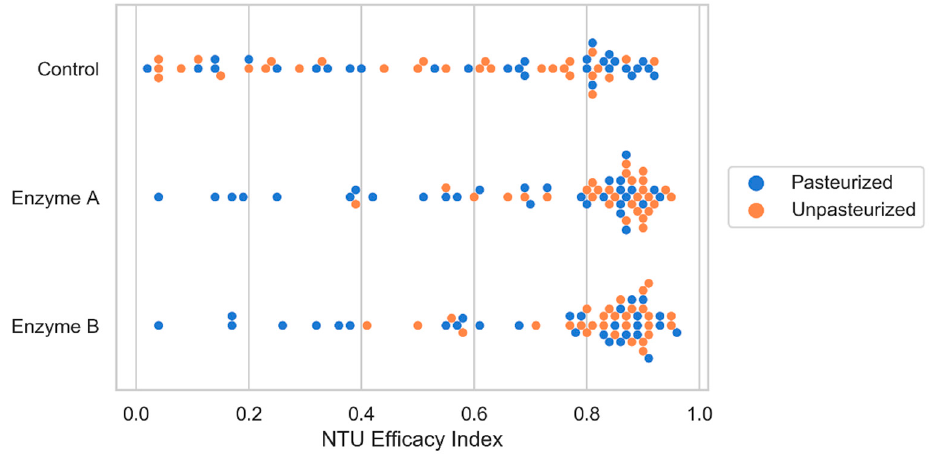
Figure 2. Effect of juice pasteurization on clarification behavior and enzyme